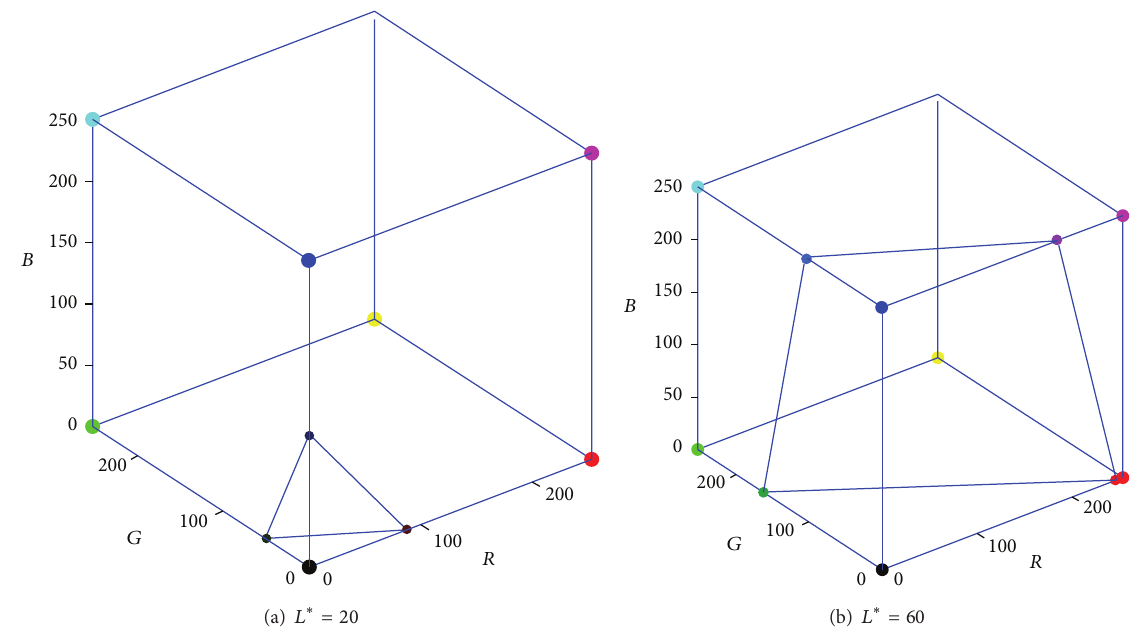
Figure 3: The scattered constant-lightness gamut boundary on RGB cube’s edges.